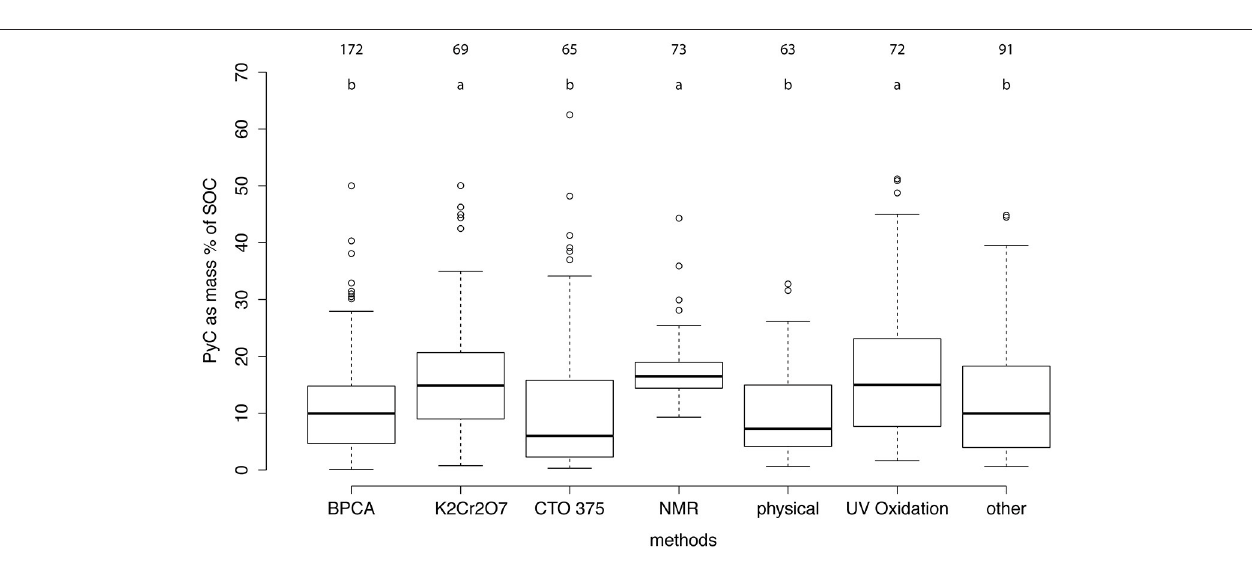
FIGURE 2 | PyC content as mass % of the total SOC as a function of the methods used in the literature database and their respective PyC content distribution as mass % of total SOC. One-Way-ANOVA for the methods results in a p < 0.001. The different letters on the top indicate significant differences ( p < 0.05 TukeyHSD test) between the